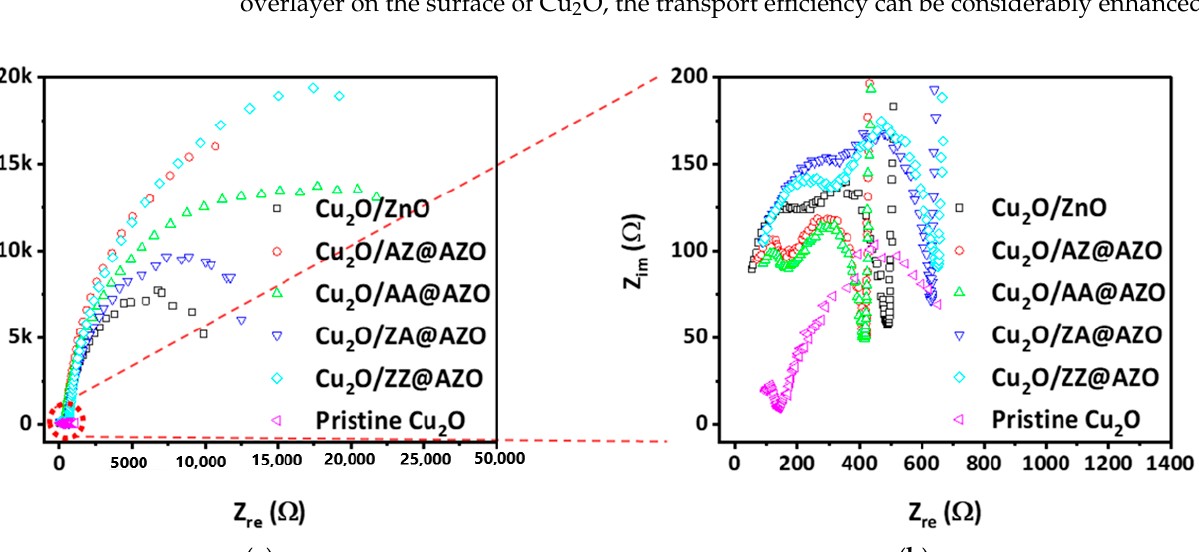
Figure 3. ( a ) I-V graphs of ZnO and AZO overlayers on ITO substrates; ( b ) Resistivity values from the 4-point probe method of 20- nm-thick ZnO and AZO thin films on glass substrates.